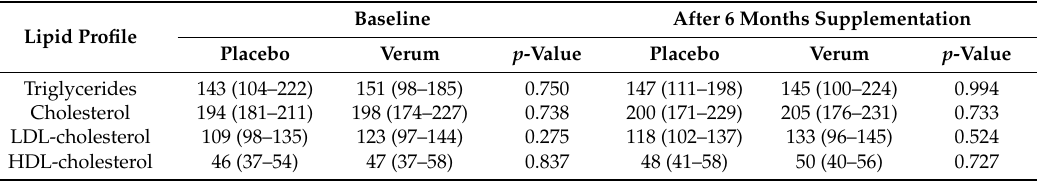
Table 2. Blood lipid levels at baseline and after 6 months of